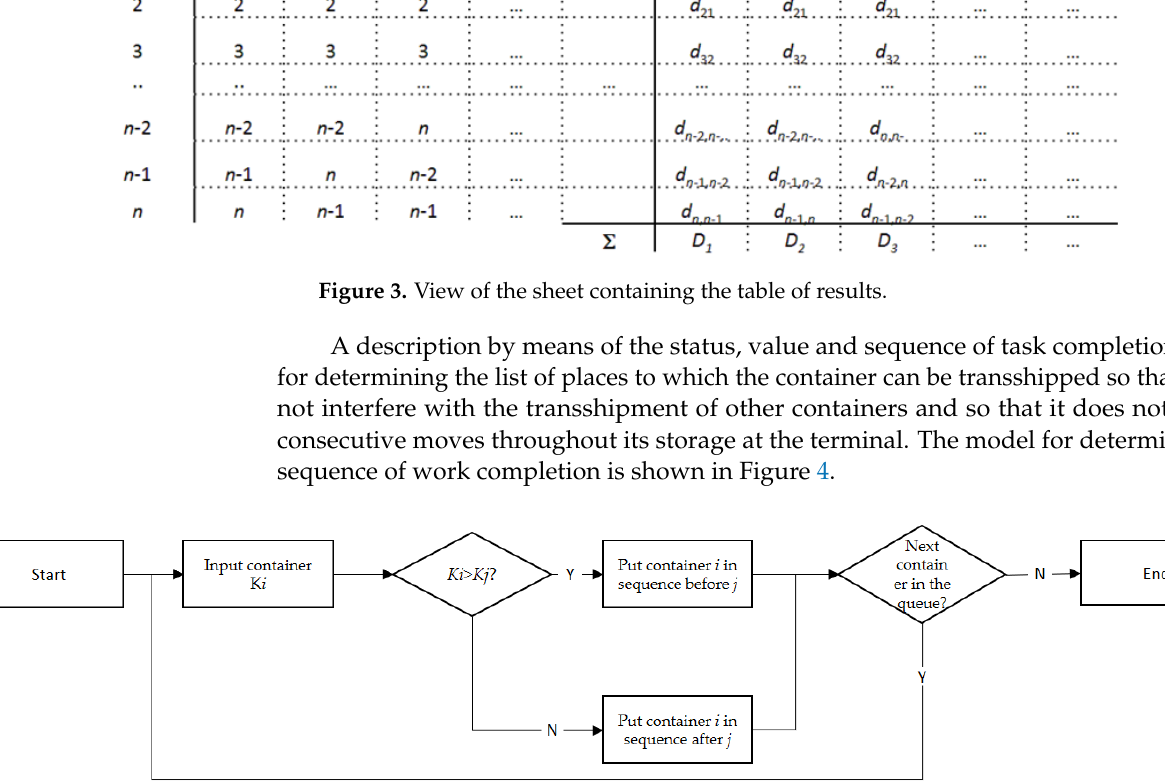
Figure 4. Model for determining the sequence of container handling.